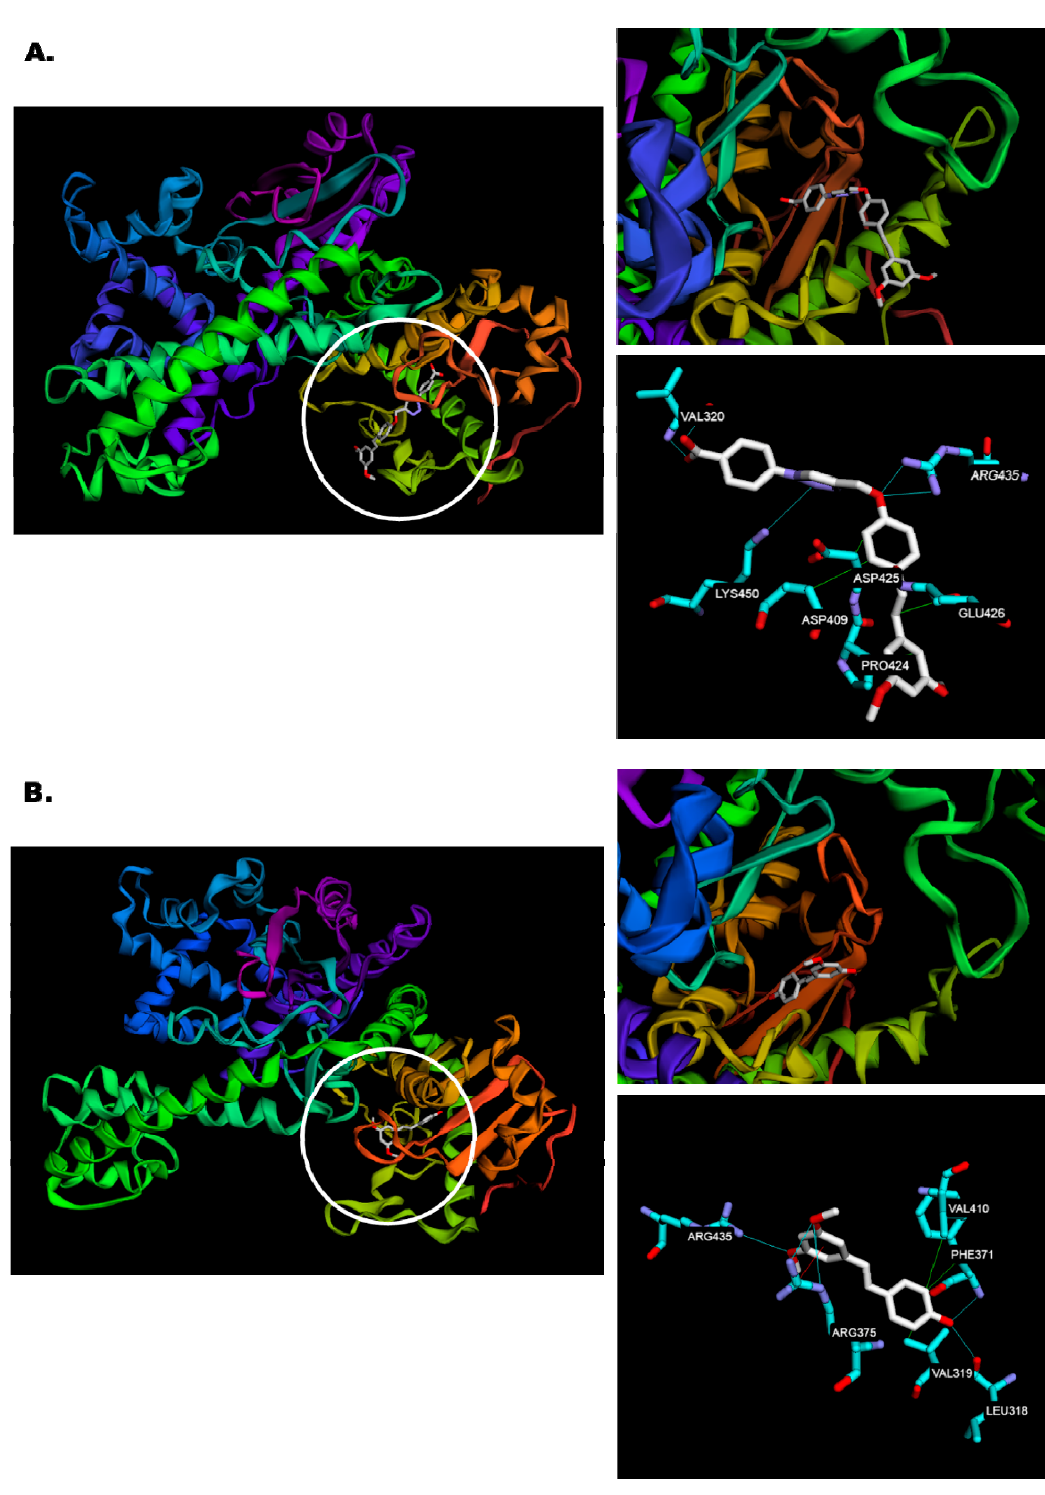
Figure 6. Docking pose of ( A ) compound 4d and ( B ) pterostilbene at DNA polymerase (PDB code 4b9t). The white circle illustrated the possible active binding site of ( A ) compound 4d and ( B ) pterostilbene on DNA polymerase. The interaction illustrated by green lines represent hydrophobic interaction, blue lines represent hydrogen bonding, and red lines represent PI–cation interaction.